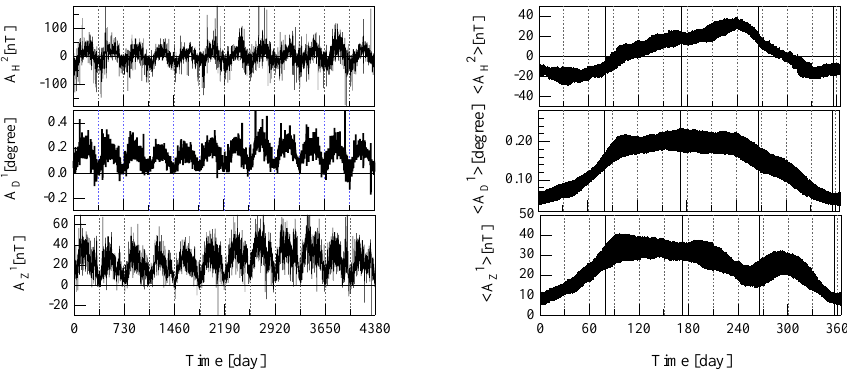
Fig. 4. The PCs associated with the EOFs reported in Fig. 3 for H, D and Z magnetic field elements (left panels) and the average annual behavior of PCs as evaluated applying the superposed epoch analysis (right panels). The vertical solid lines in right panels indicate the equinoxes and